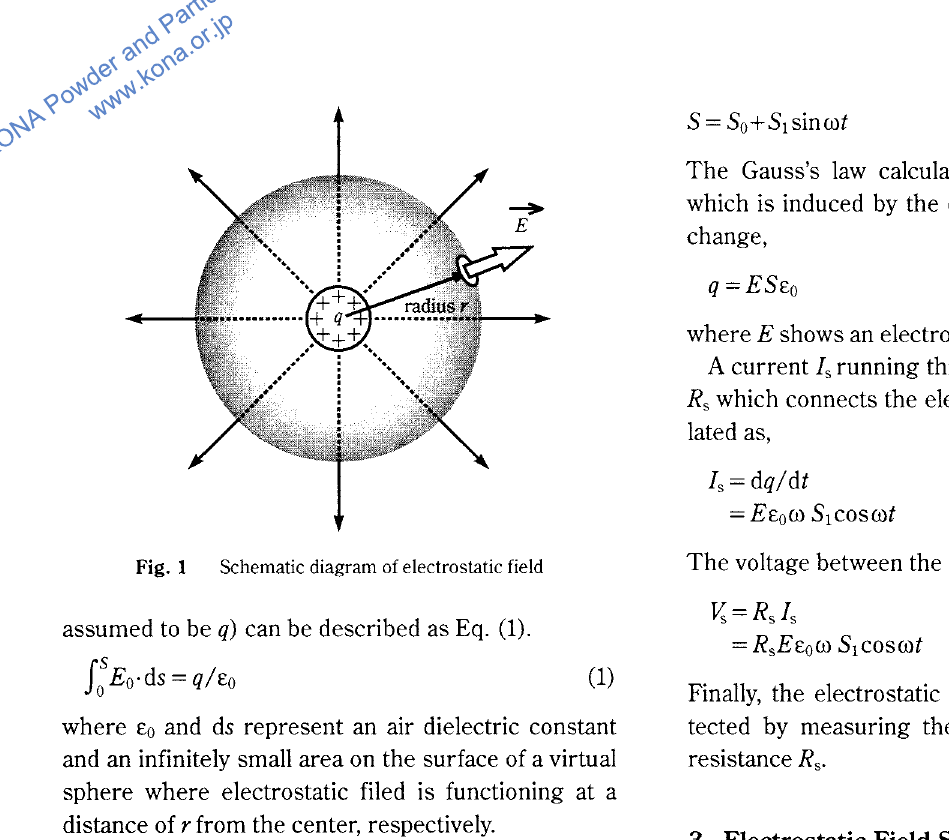
Fig. 1 Schematic diagram of electrostatic field